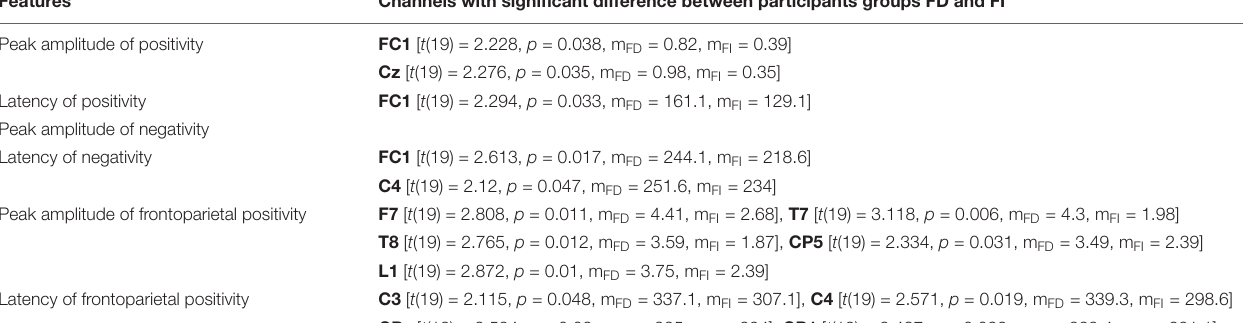
TABLE 3 | Channels that showed significant difference between participant groups FD and FI, for all features.